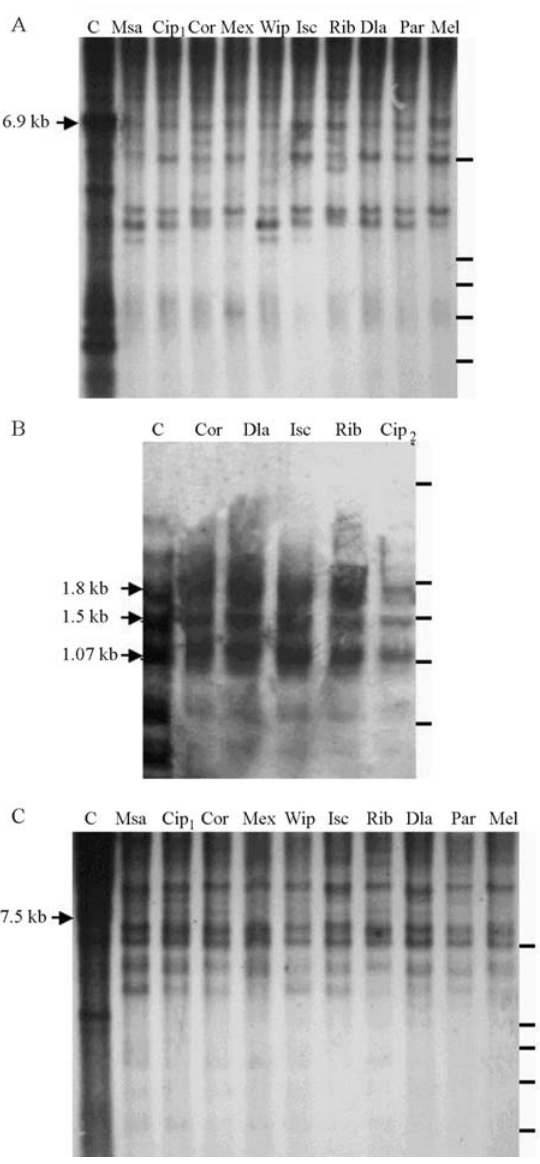
Figure 4 - Southern blot hybridization of genomic DNA from Drosophila willistoni strains probed with a 6.9 kb fragment liberated by the Xho I re- striction enzyme from the gypsy retroelement of the Drosophila melanogaster pGGHS plasmid, lane C is D. melanogaster (Harwich strain). The Genomic DNA from the different D. willistoni populations was digested with Xho I (A), Ava II (B) or Bam HI (C). Arrows indicate the fragments expected for D. melanogaster . Bars on the right represent the 1 kb Plus DNA Ladder (Invitrogen) fragments (5, 2, 1.65, 1 and 0.5